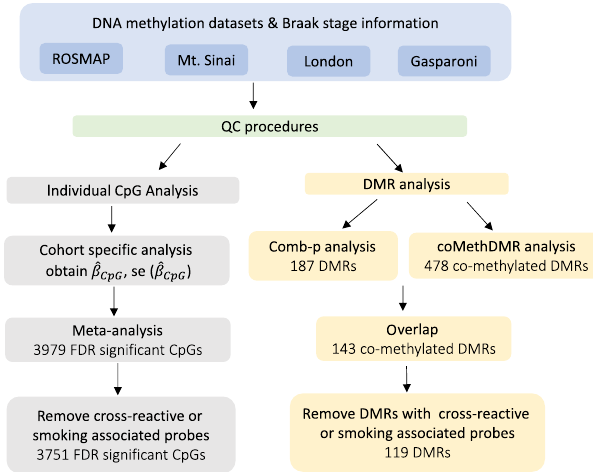
Fig. 1 Work fl ow of meta-analysis for individual CpGs and